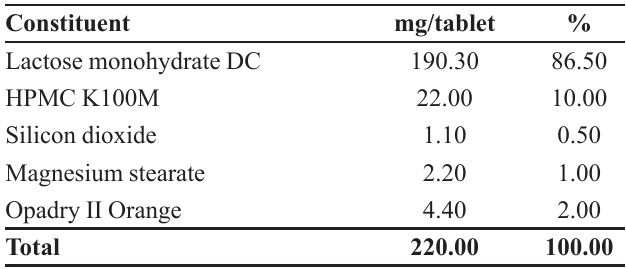
TABLE II – Composition of the powder mixture for compression- coating